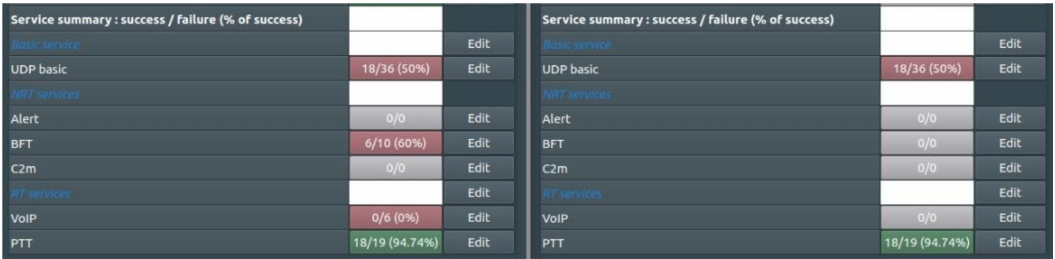
Figure 23. Summary of services realization in the case without an integrated